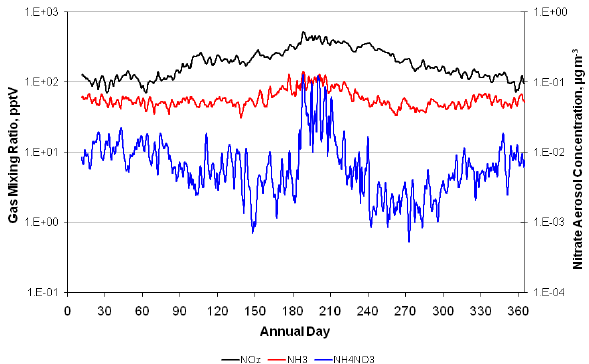
Fig. 4. Grid-averaged time series of NO z , NH 3 and ammonium nitrate aerosol for the natural emissions simulation of 2002. Diurnal noise was removed by applying a 24-hr averaging filter.